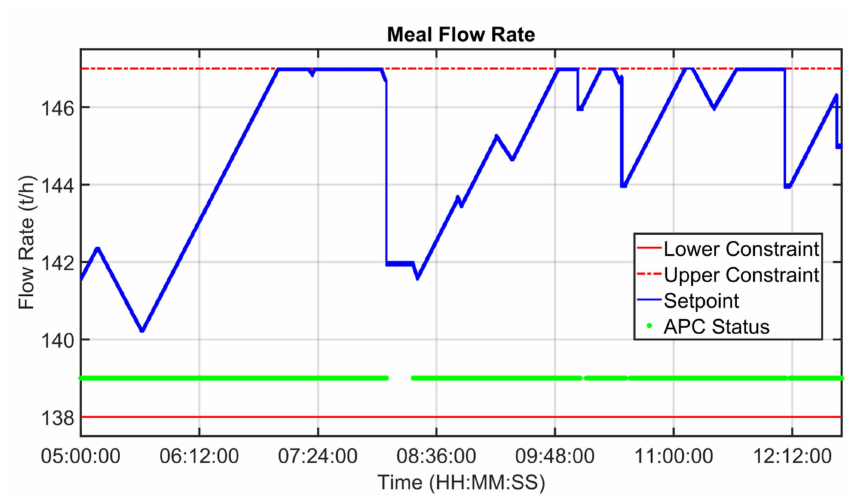
Figure 24. Rotary kiln APC system: field results (meal flow rate MV).